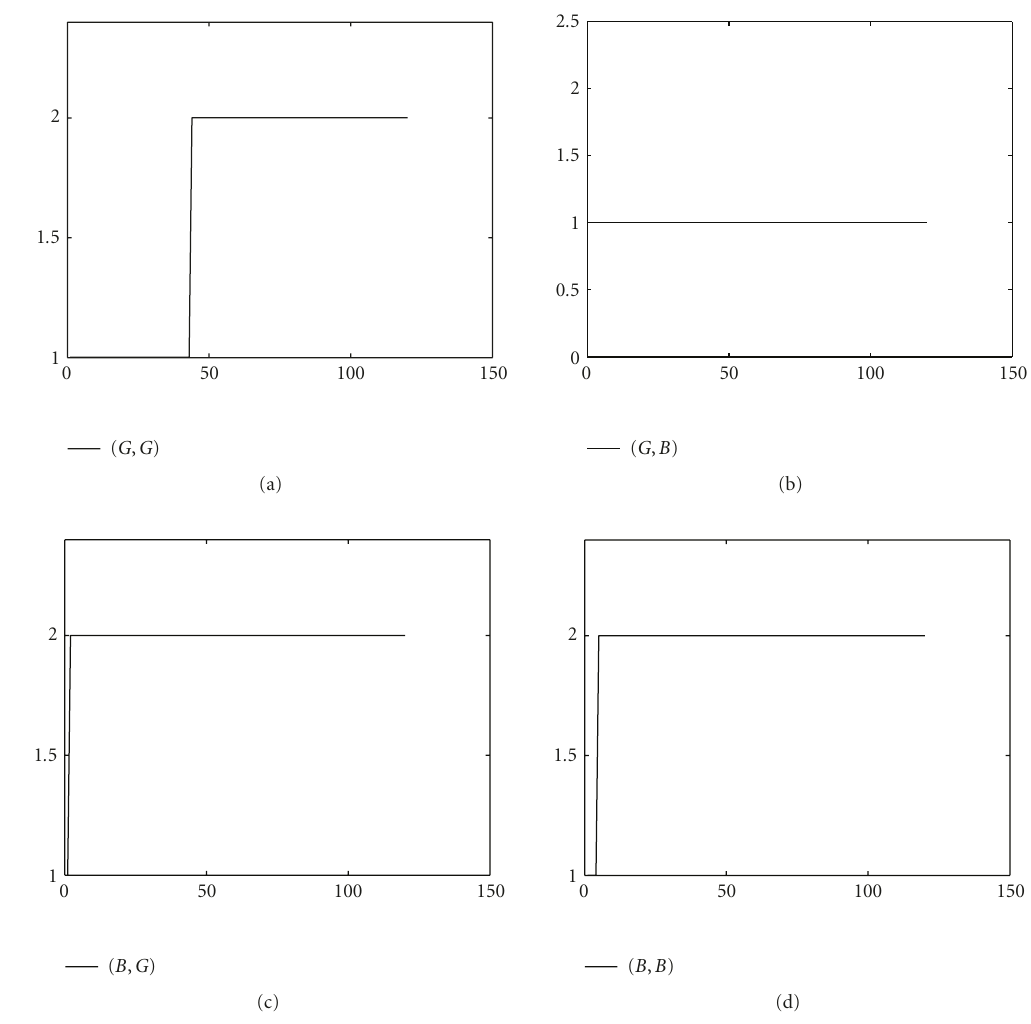
Figure 5: Link scheduling with bu ff er load control. When both links are in the good state and the bu ff er level exceeds a certain level, there is a switch of transmission from the incoming link to the outgoing link. Horizontal axis: bu ff er level; vertical axis: scheduler state.